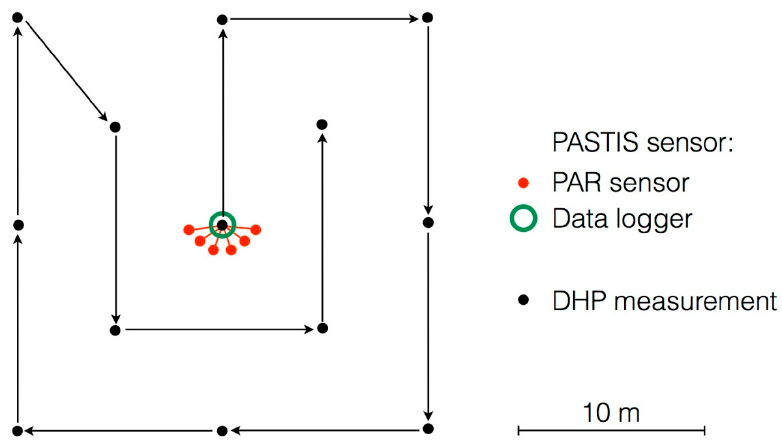
Figure 2. Spatial sampling for DHPs collection at each ESU. Every black circle stands for a DHP acquisition, while arrows indicate the path followed during the sampling at every ESU. PASTIS device consist of a data logger (green empty circle) and six PAR sensors (red circles). The first DHP acquisition is made at the PASTIS installation.